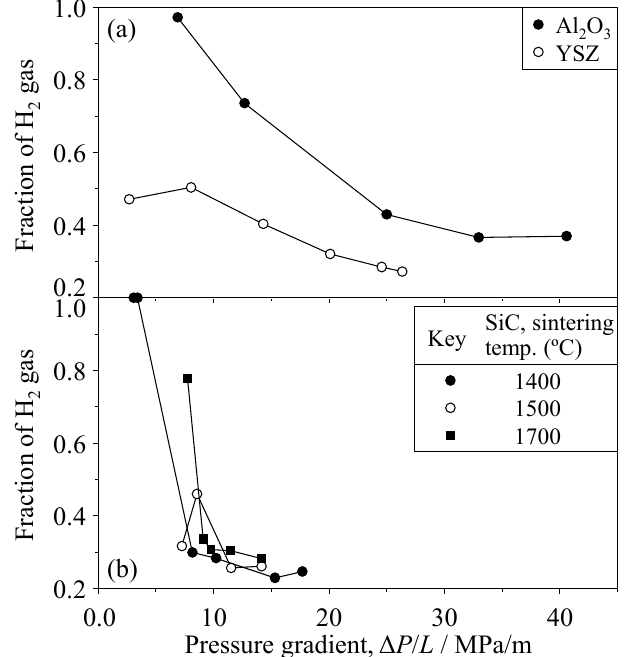
Figure 14. Fraction of H 2 gas for the 20 vol % H 2 –80 vol % CO 2 mixed gas through ( a ) Al 2 O 3 and YSZ and ( b ) SiC.